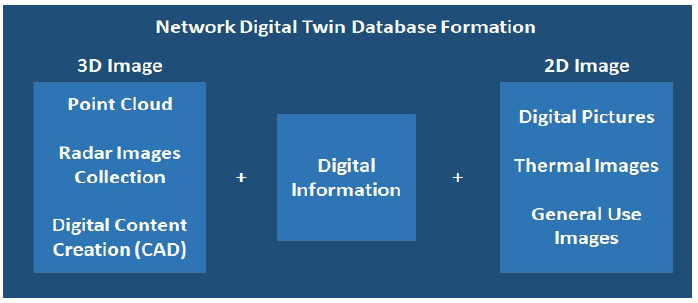
Figure 7. DT images gathered